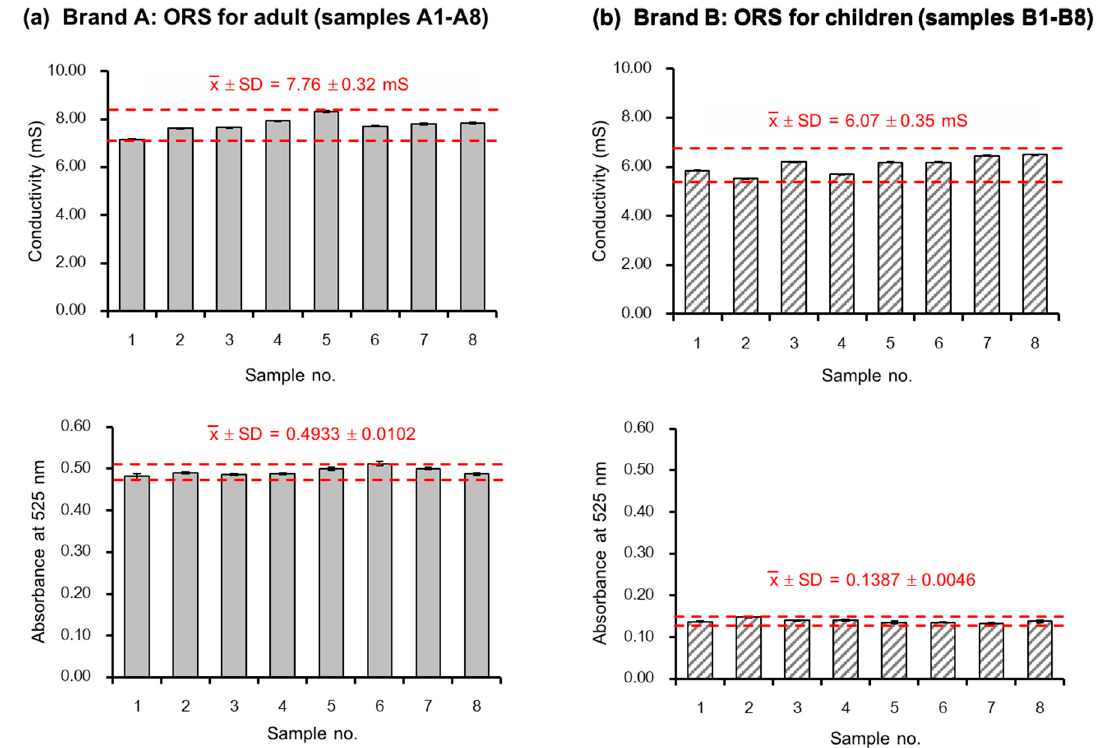
Figure 4. Bar graphs of the mean conductivity (mS cm − 1 ) of each sachet (dose) and the mean absorbances of 150.0 mL solutions for Brand A or 120.0 mL solutions of Brand B, with error bars ( n = 3). The red text shows the means and standard deviations for samples A1–A8 and for samples B1–B8, respectively. The red dotted lines indicate the range for the mean ± 2SD of these two products. ( a ) Eight samples from “Brand A” for adults, labelled net weight of 3.645 g. ( b ) Eight samples from “Brand B” for children, labelled net weight of 3.3 g.